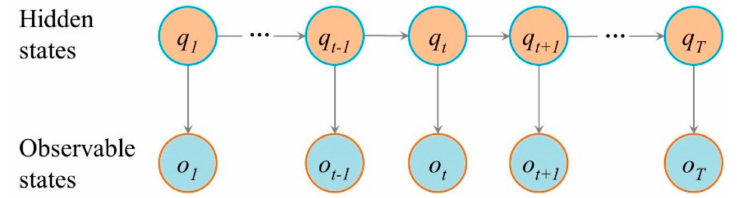
Figure 3. An HMM represented as a probabilistic network.